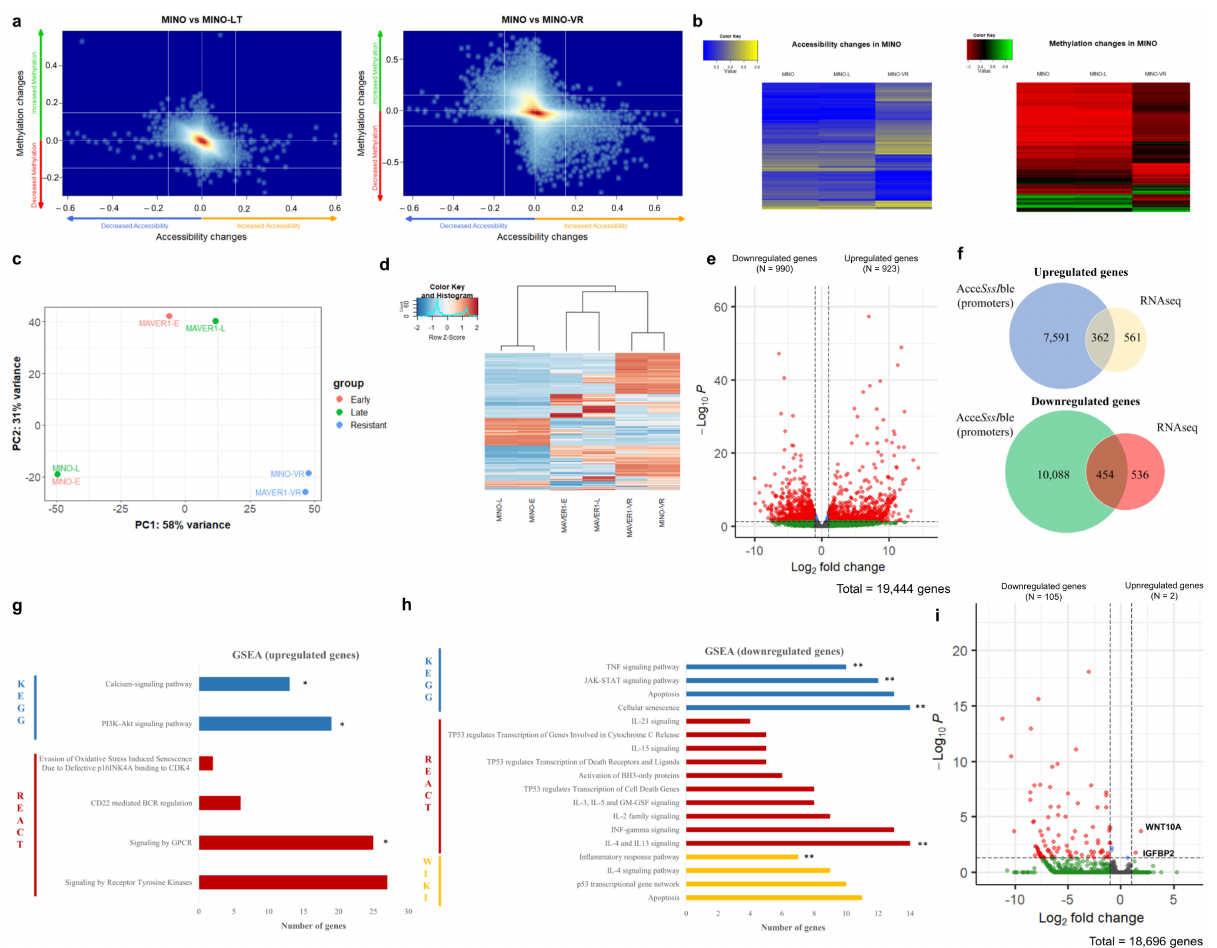
Figure 3. ( a ) Kernel density plot of the combined DNA methylation changes and chromatin accessibil- ity changes observed in MINO-LT (left) and MINO-VR (right) cell lines in comparison to the paternal MINO cell line. Each dot represents an Illumina probe, delta-accessibility and delta-methylation of the corresponding comparison, with a significant difference threshold of ± 15%. ( b ) Heatmaps of raw accessibility (left) and DNA methylation (right) values for MINO, MINO-LT and MINO-VR for all Illumina probes with an accessibility and/or methylation difference of ± 15% compared to the paternal MINO. ( c ) Principal component analysis (PCA) plot from RNA-seq data for all cell lines, depicting their relative transcriptome proximity. ( d ) Heatmap with unsupervised clustering including the 500 most variable genes among all cell lines. ( e ) Volcano plot with the differentially expressed genes between the VR cell lines and paternal cell lines (dark grey: no significant change, green: absolute log2-fold change > 2, but adjusted p -value > 0.05, red: absolute log2-fold change > 2, and adjusted p -value ≤ 0.05). ( f ) Venn diagrams showing the overlap between upregulated Acce SssI ble promoters and upregulated genes by RNA-seq (upper) and between downregulated Acce SssI ble promoters and downregulated genes by RNA-seq (lower). ( g ) Gene set enrichment analysis (GSEA) for the upregulated genes from RNA-seq analysis. The asterisks show the overlapping pathways from GSEA using the upregulated Acce SssI ble promoters. ( h ) Gene set enrichment analysis (GSEA) for the downregulated genes from RNA-seq analysis. The double asterisks demonstrate the overlapping pathways from GSEA using the downregulated genes from RNA-seq analysis of MS-5 co-cultures (microenvironment-induced resistance). ( i ) Volcano plot with the differentially expressed genes between the MS5 co-cultured cell lines and HS-5 co-cultured cell lines (dark grey: no significant change, green: absolute log2-fold change > 2, but adjusted p -value > 0.05, red: absolute log2-fold change > 2, and adjusted p -value ≤ 0.05). * p < 0.05 and ** p <